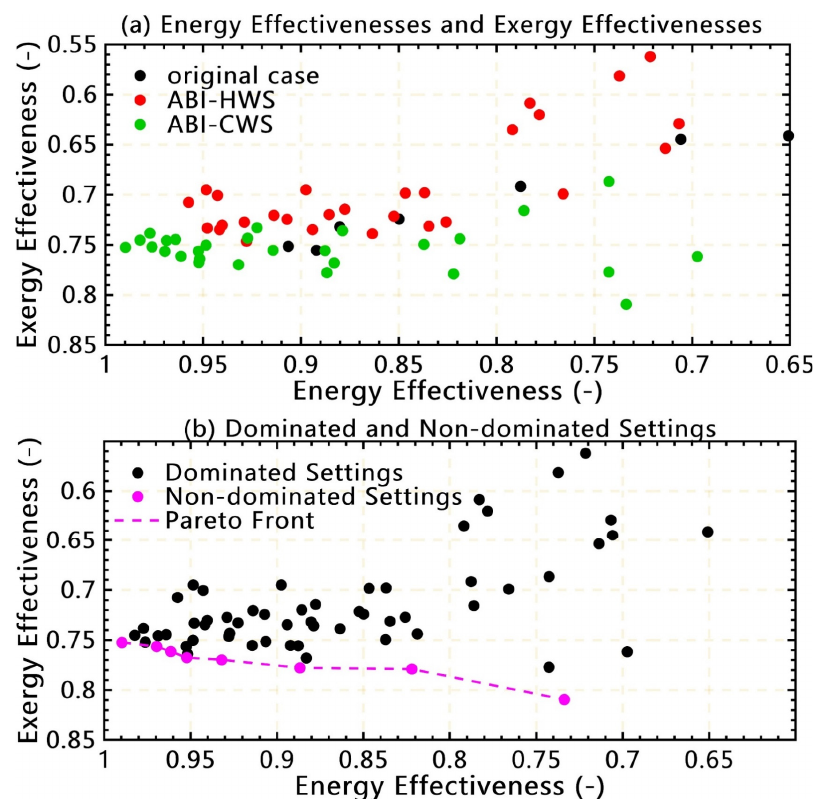
Figure 15. Pareto-front of 𝜀 vs.𝜀 (cid:3032)(cid:3051) at different operating conditions.